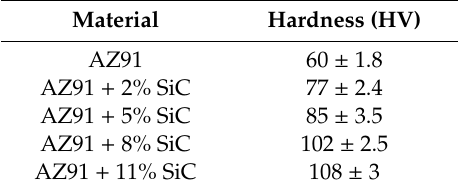
Table 4. The ultimate tensile strength and yield strength.